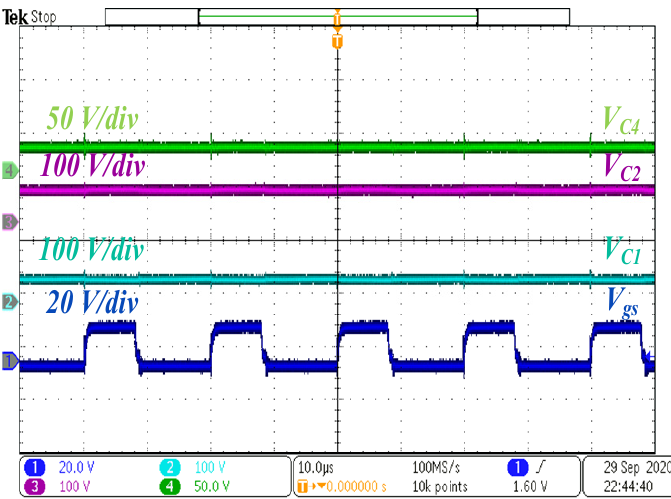
Figure 16. Capacitor voltages of C 1 , C 2 , and C 4 at D = 0.4.